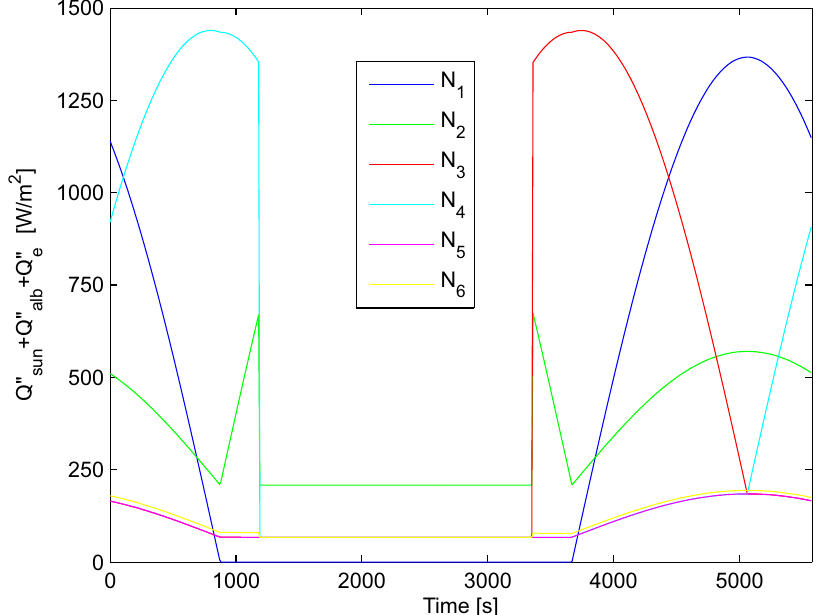
Figure 10. Total irradiance flux for each side of the CubeSat and average temperature. Orbit with TLE1, β = 0 ◦ , date 10/01/15, 00:00 am, attitude Nadir and perturbation “Drag: NRLMSISE-00, J 2 ”.